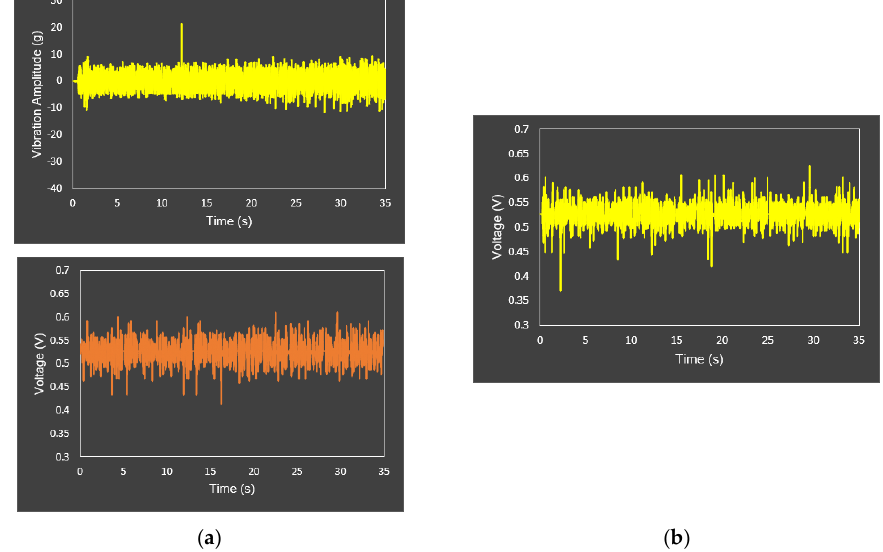
Figure 17. CPMA data displays: ( a ) MEMS accelerometer and piezoelectric sensor data for the first machine; ( b ) piezoelectric sensor data for the second machine.